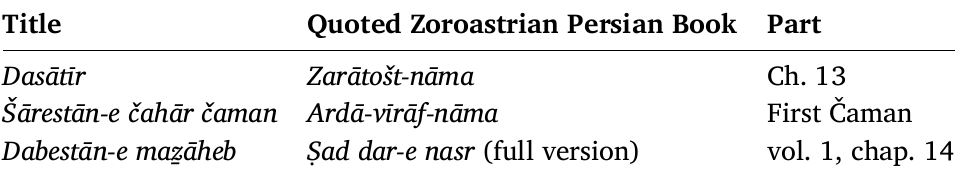
Table 4 Quotations from traditional Zoroastrian New Persian Literature in books of the Āẕar Kaivān School. Quoted Zoroastrian Persian Book Part Dasātīr Zarātošt-nāma Ch. 13 First Čaman Ṣad dar-e nasr (full version) vol. 1, chap.